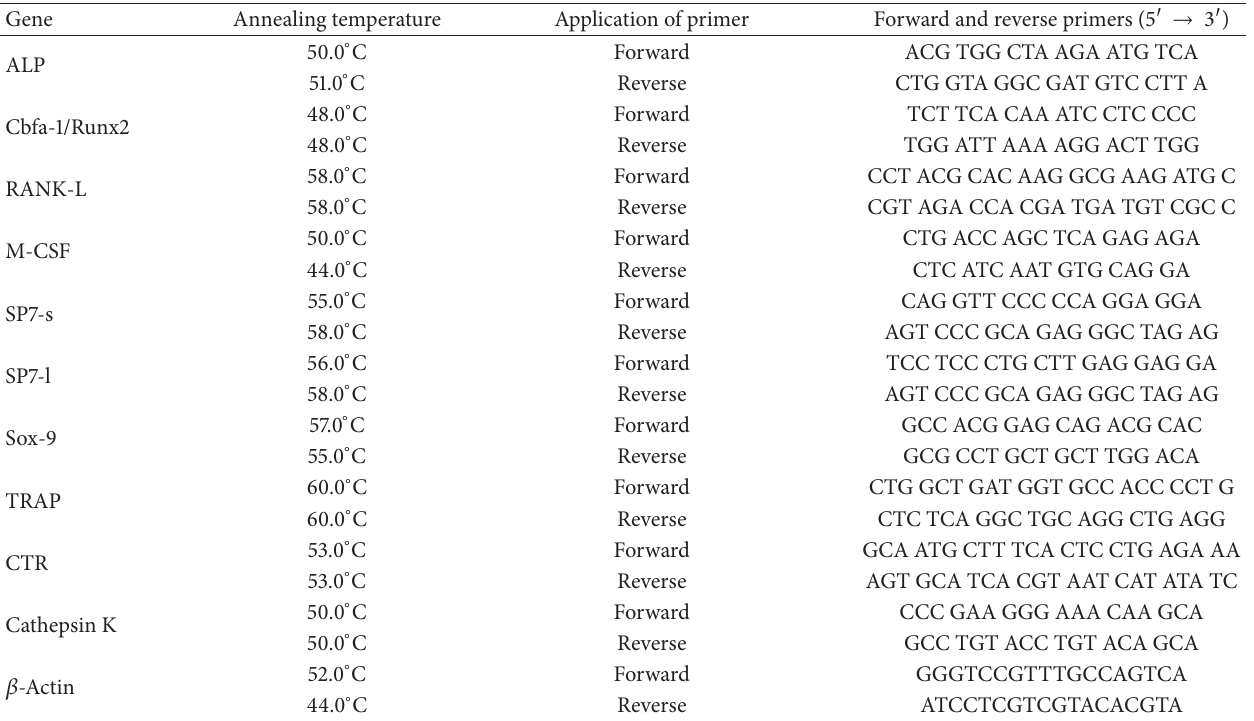
Figure 1: (a) Conventional light microscopy. Hematoxylin and eosin-stained periosteum samples showing the cell rich cambium layer and the upper fibrous layer. (b) Fluorescence microscopy demonstrating a DAPI stain showing the distribution of nuclei (blue). Table 1: Specific primers used for